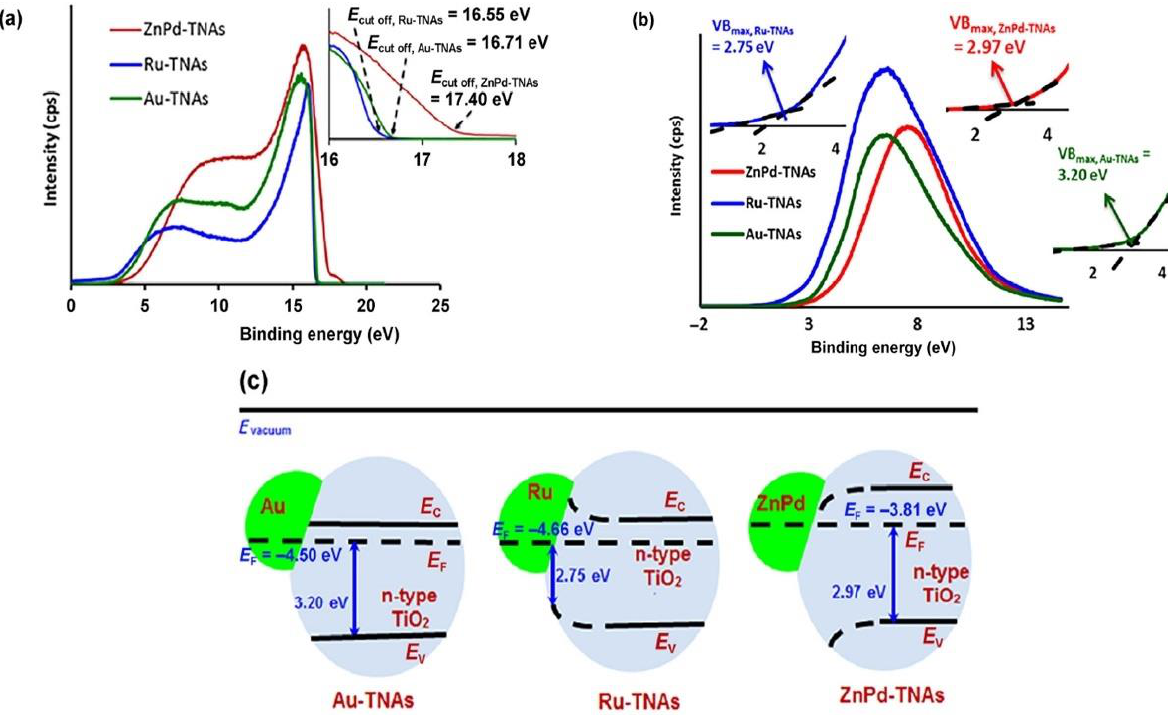
Figure 8. Kar et al. [155] utilized UPS to characterize band energetics in their work on enhanced CH 4 yield via photocatalytic CO 2 reduction using TiO 2 nanotube arrays (TNAs) grafted with Au, Ru, and ZnPd nanoparticles (NP). In ( a ) the work functions of Au-TNA, Ru-TNA, and ZnPd-TNA are extracted to equal 4.50, 4.66, and 3.81 eV, respectively. In order to determine the positions of the valence band maxima for each structure, ( b ) UPS high binding energy cut-off spectra are utilized with cut-off energies at 3.20, 2.75, and 2.97 eV in Au-TNA, Ru-TNA, and ZnPd-TNA, respectively. The importance of these measurements is illustrated in ( c ), where the band structures of the noble metal–semiconductor composites are elucidated. Since a He laser of incident energy 21.21 eV was utilized, the work function can be calculated from the expression 21.21—E cut-off , where E cut-off is the cut-off energy. Given the earlier values found in ( a , b ), the band-bending at the NP-TNA interfaces is measured. Thus, the UPS spectra assist in the significant observation of the differing band bending dynamics that occur in TNAs in contact with Ru NPs (upward bending) and TNAs in contact with ZnPd NPs (downward bending). This is particularly helpful in facilitating hypotheses and discussions on the charge transfer dynamics that may occur in such composite systems involving metal NP co-catalysts on metal oxide semiconductor supports, and their subsequent use as potential photocatalysts for a variety of chemical reactions. Reprinted with permission from Ref [155] Copyright Springer Nature (2016).